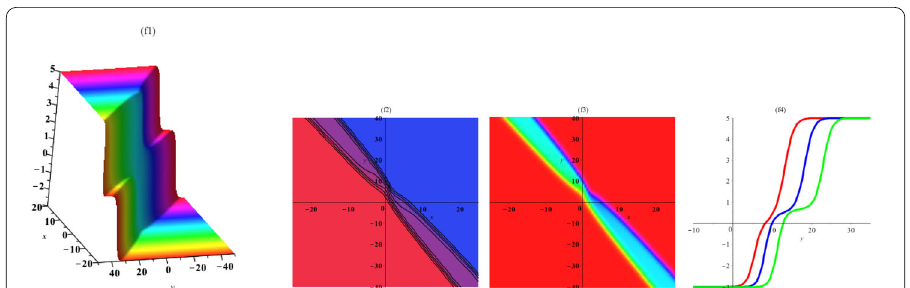
Figure 8 The plot of lump–soliton (5.11) with fractional order α = 0.5